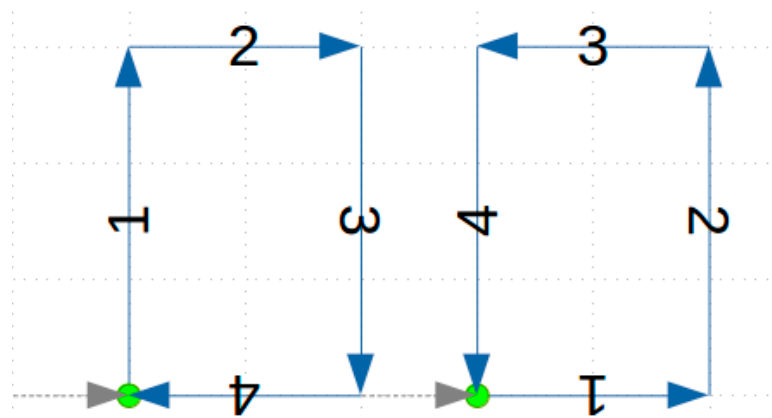
Figure 8. A test pattern to verify feature repeatability and backlash compensation effectiveness. Grey dashed arrows indicate that the mill is moving above the substrate. Green Circles indicate that the tool has plunged into the surface. Blue arrows indicate the path the mill is cutting into the copper.